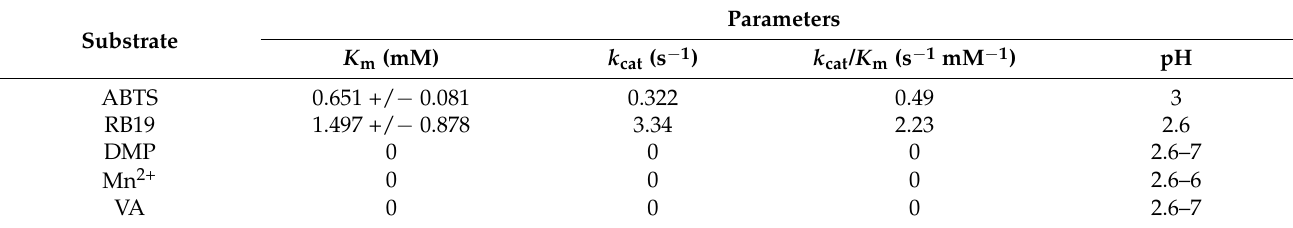
Table 4. Kinetic constants of the recombinant DyP1 produced in P. pastoris . The pH column indicates either the tested pH range or the determined optimal reaction